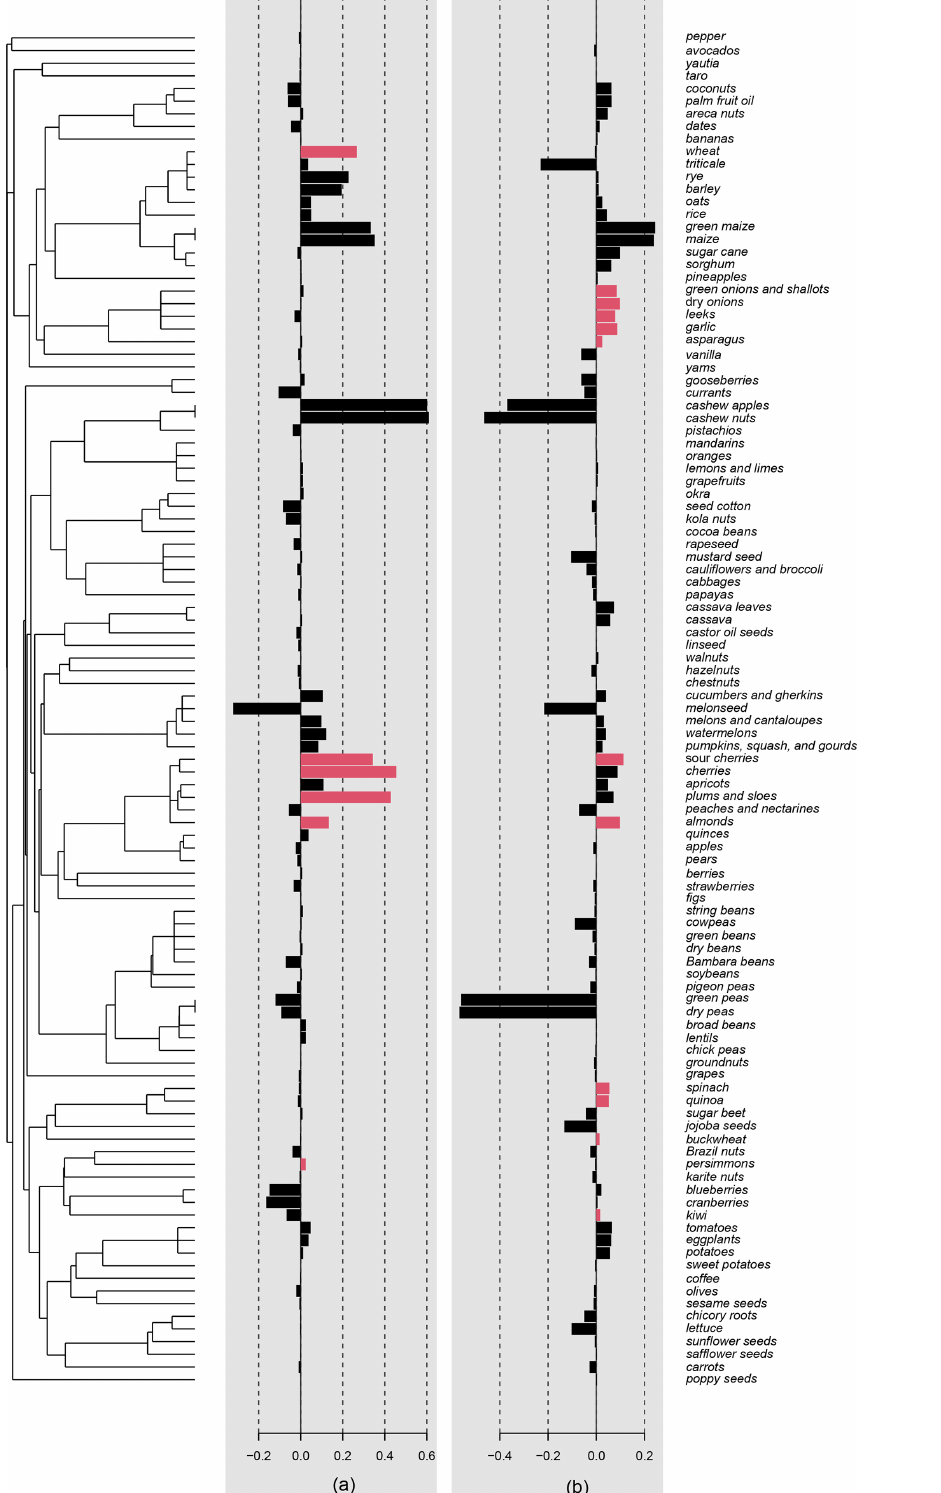
Figure A3. Local indicators of phylogenetic association (LIPA) scores for (a) (cid:49) yield and (b) SD( (cid:49) yield), depicted with a bar for each crop. Significant values ( p < 0 . 05) are indicated with colored